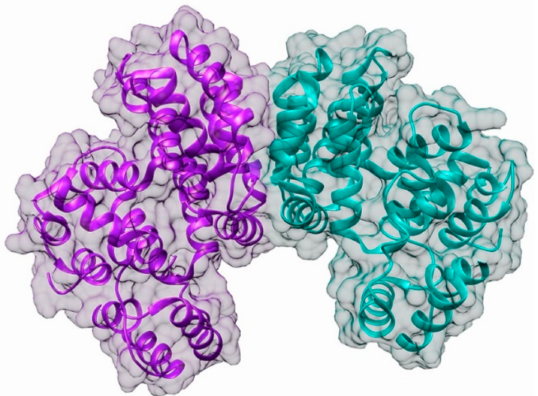
Figure 5. Putative structure of ANNEXIN1 channel. ANNEXIN1 secondary 3D structure model showing two subunits (homodimer) in transparent surface view was developed from PDB structure 1YCN ( Arabidopsis thaliana ANNEXIN). The presence of Ca 2+ or H 2 O 2 appears to be required for homodimerization. The image was prepared using Chimera software